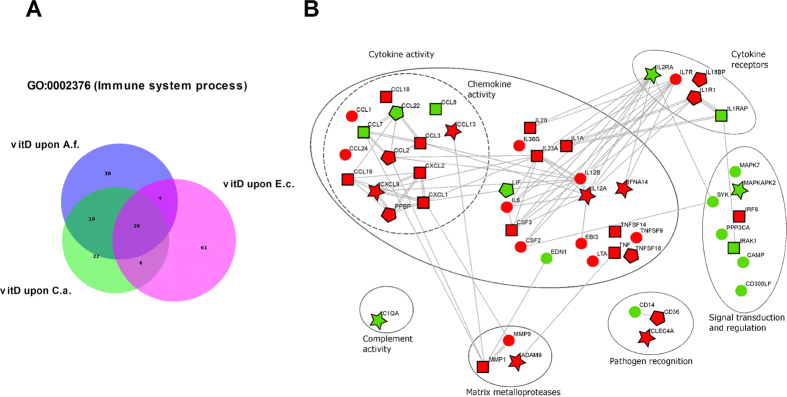
Immunomodulatory footprint of vitamin D during infection.VitD shows a pathogen-specific regulatory role on immune-relevant genes leading to an overall down-regulation of cytokines, chemokines and matrix metalloproteases. (A) Venn diagram showing the overlap and amount of vitD-regulated immune-relevant genes (GO:0002376) in each of the infections analysed: A. fumigatus (blue), C. albicans (green) and E. coli (magenta). (B) Network based on experimental and database-derived knowledge (edges) generated with the STRING database. ○ vitD regulated these genes in at least two of the pathogenic infection settings;  vitD-regulated genes during C. albicans infection; □ vitD-regulated genes during E. coli infection;  vitD-regulated genes during A. fumigatus infection; red: down-regulation, green: up-regulation.